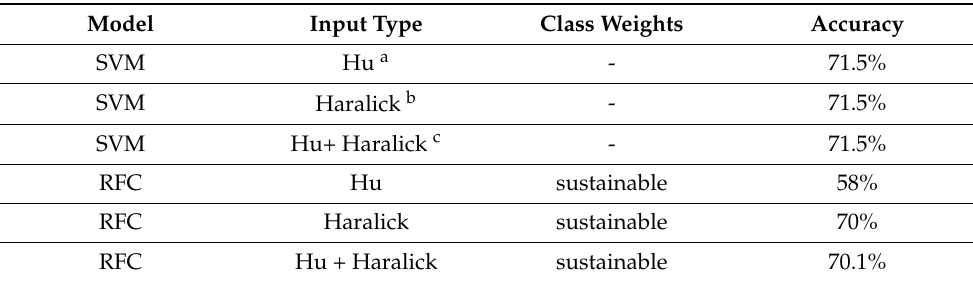
Table 1. Results of binary classification with the use of classical classifiers, using Hu moments and Haralick